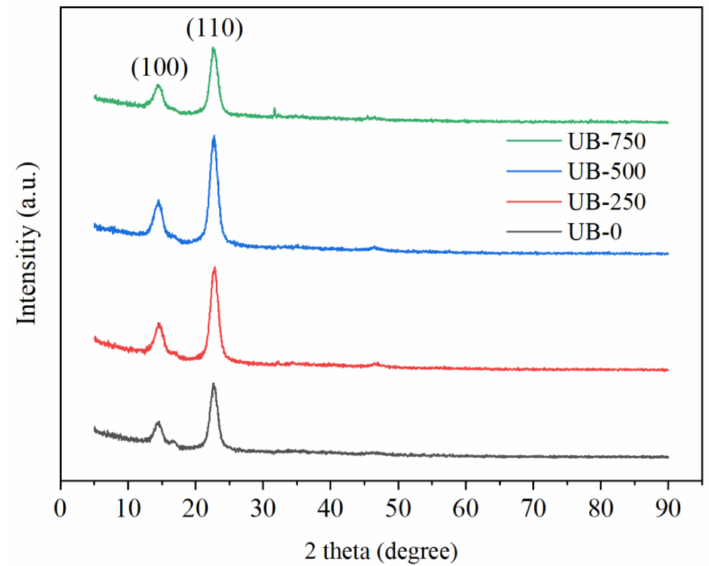
Figure 6. X-ray diffraction patterns of